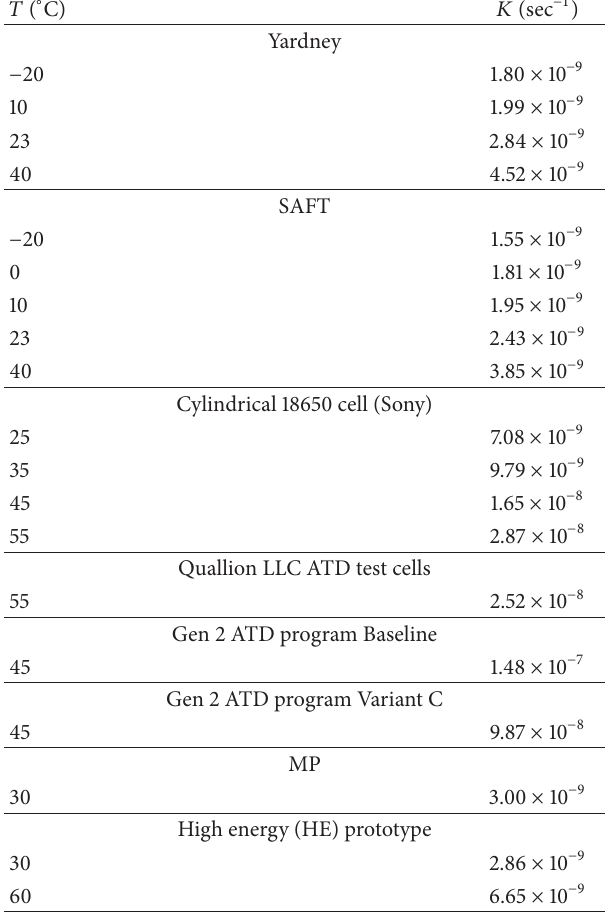
Table 3: Dependence of rate constants on temperature. Values of reaction rate constants for different cells.